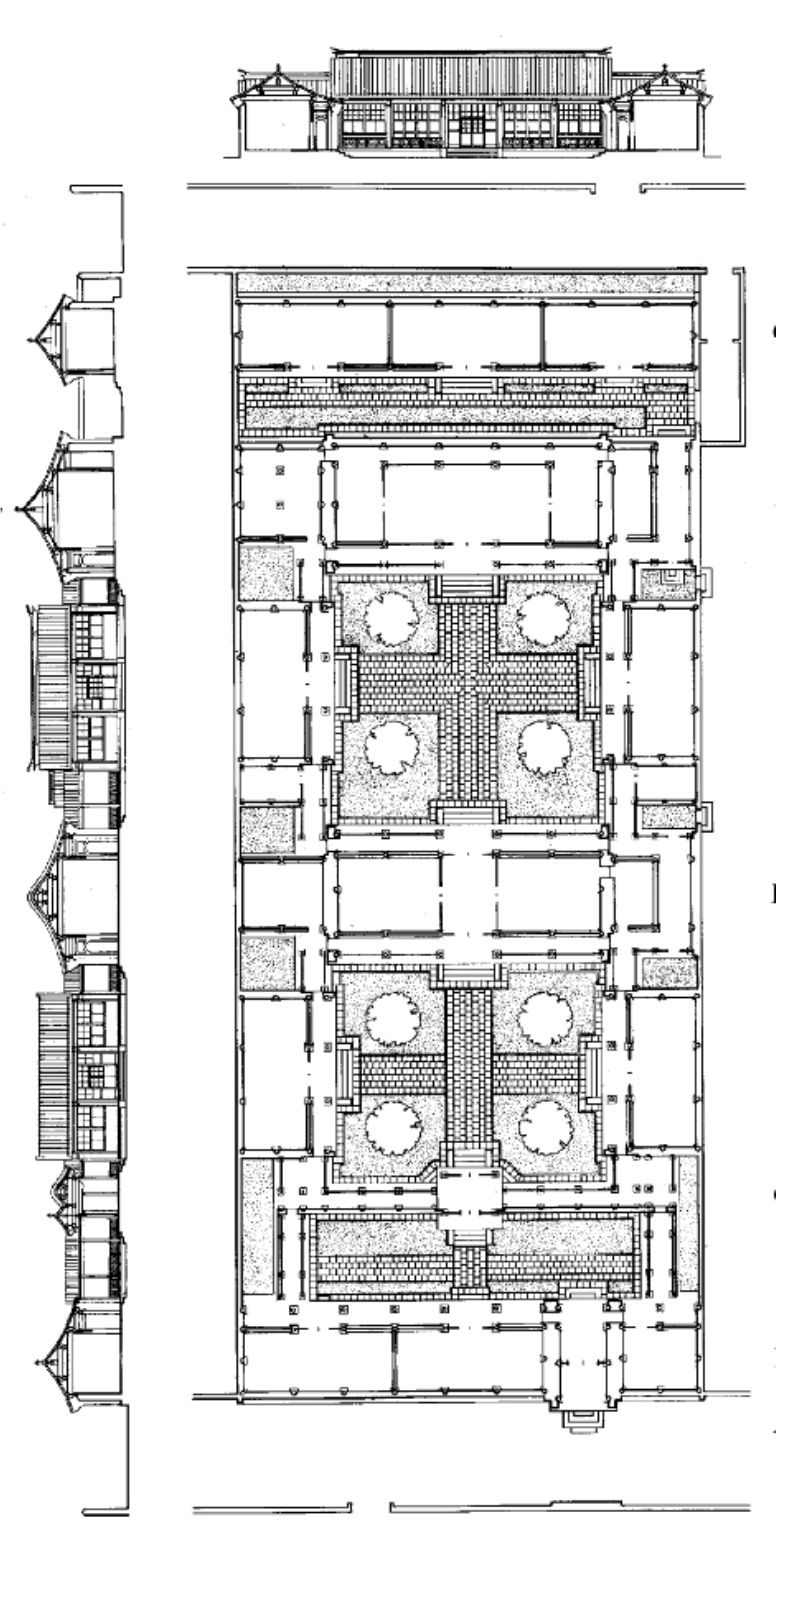
Figure 15. Siheyuan plan and section